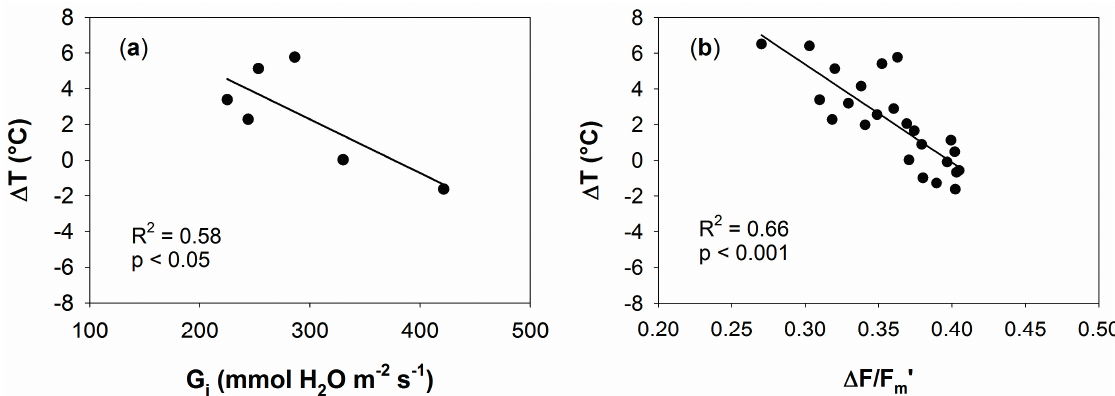
Figure 3. Relationship between image-based Δ T and ground measured instantaneous stomatal conductance (G i , mmol H 2 O m − 2 s − 1 ) ( a ) and fluorescence yield ( Δ F/F m ') ( b